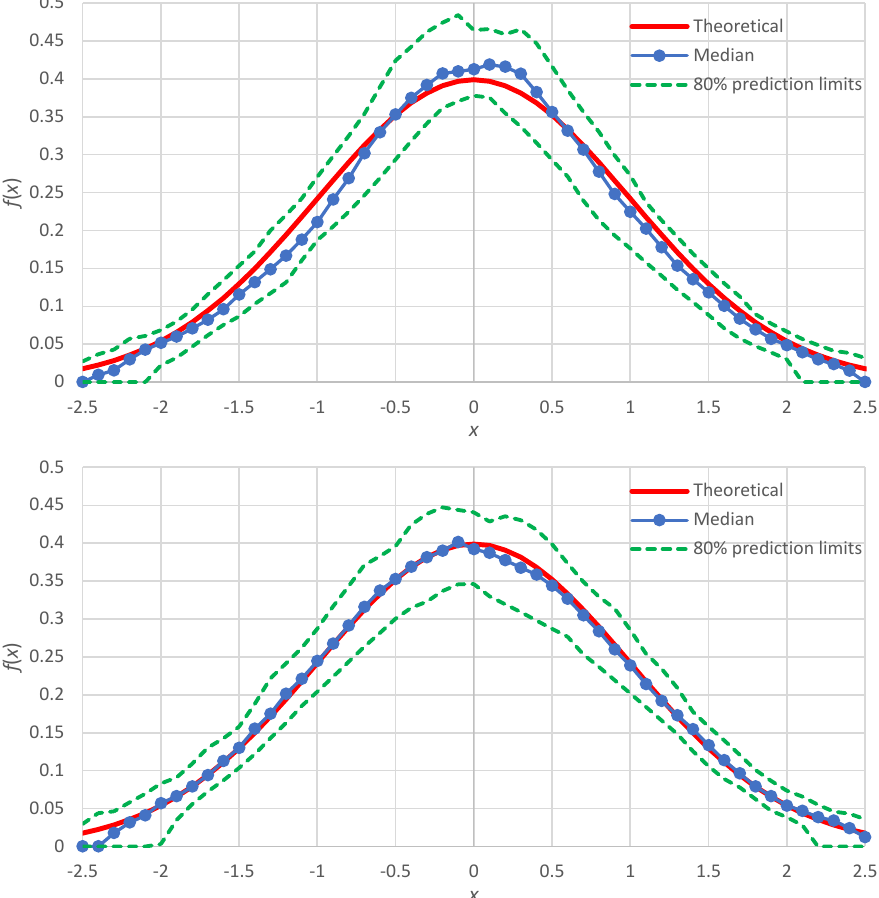
Figure 6. Comparison of the Monte Carlo simulation results for the normal distribution (with parameters as in Table 4) with the minimal version of the method ( upper ; copy of the upper panel of Figure 3) and the enhanced version ( lower ; using Equations (46) and (47)).